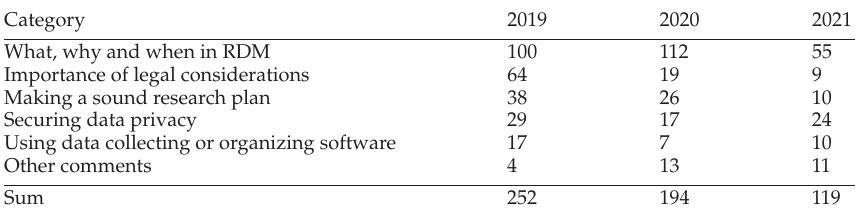
Table 3: What are the three things you have learned? Category